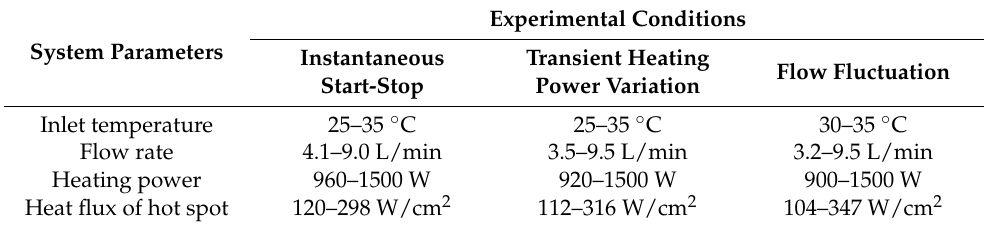
Table 5. Experimental system parameters